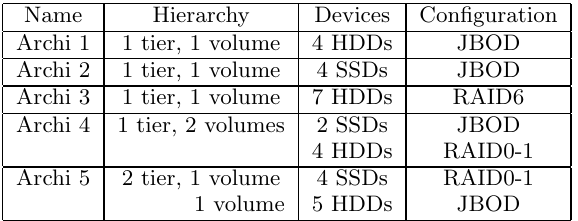
Table 3: The test bed storage systems